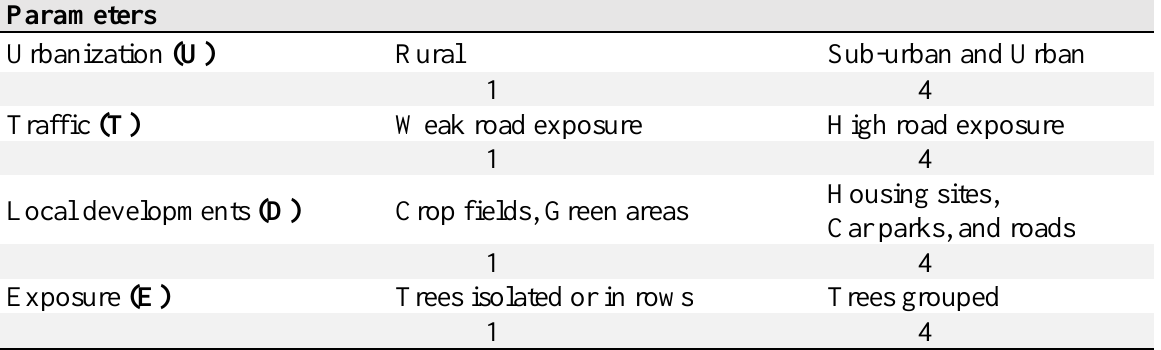
Table 1. Assessment of quantitative variables from general qualitative environmental variables (urbanization, traffic and local developments) by an increase of artificiality and from local environmental conditions (exposure) (G OMBERT et al.,